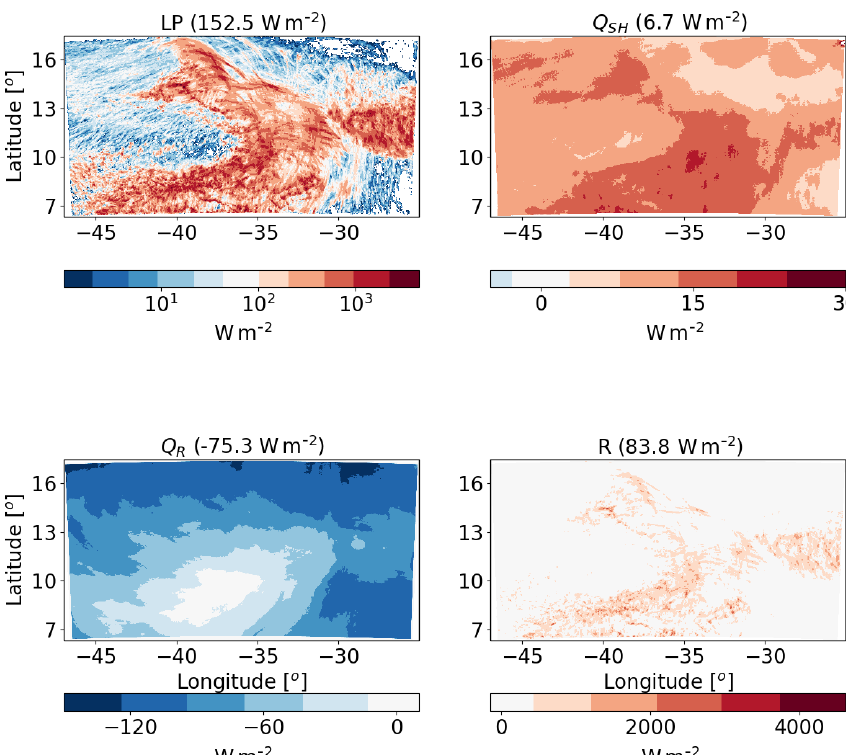
Figure 12. Spatial distribution of the time mean of the different terms of the energy budget for the ICON simulation of the deep-cloud- dominated case (16–18 August 2016) with CDNC = 20cm − 3 . The terms that appear here are as follows: LP – latent heat by precipitation, Q SH – sensible heat flux, Q R – atmospheric radiative warming – and R – the energy imbalance. The domain- and time-mean value of each term appear in